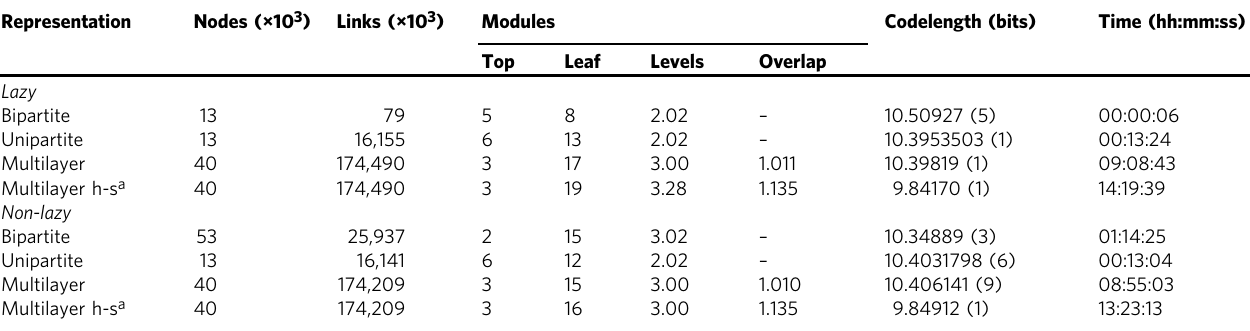
The number of nodes includes state nodes for the multilevel representations and the bipartite non-lazy representation. The partitions ’ number of non-trivial top and leaf modules. Theaverage number of levelsisweightedby fl owvolume.Wequantifythemoduleoverlapbytheeffectivenumberofnodeassignmentsintheoptimalsolutions(seeMethods).Shortestcodelengthof20trialswiththevariance in parenthesis. The elapsed time during 20 optimisation trials. a Hyperedge-similarity.